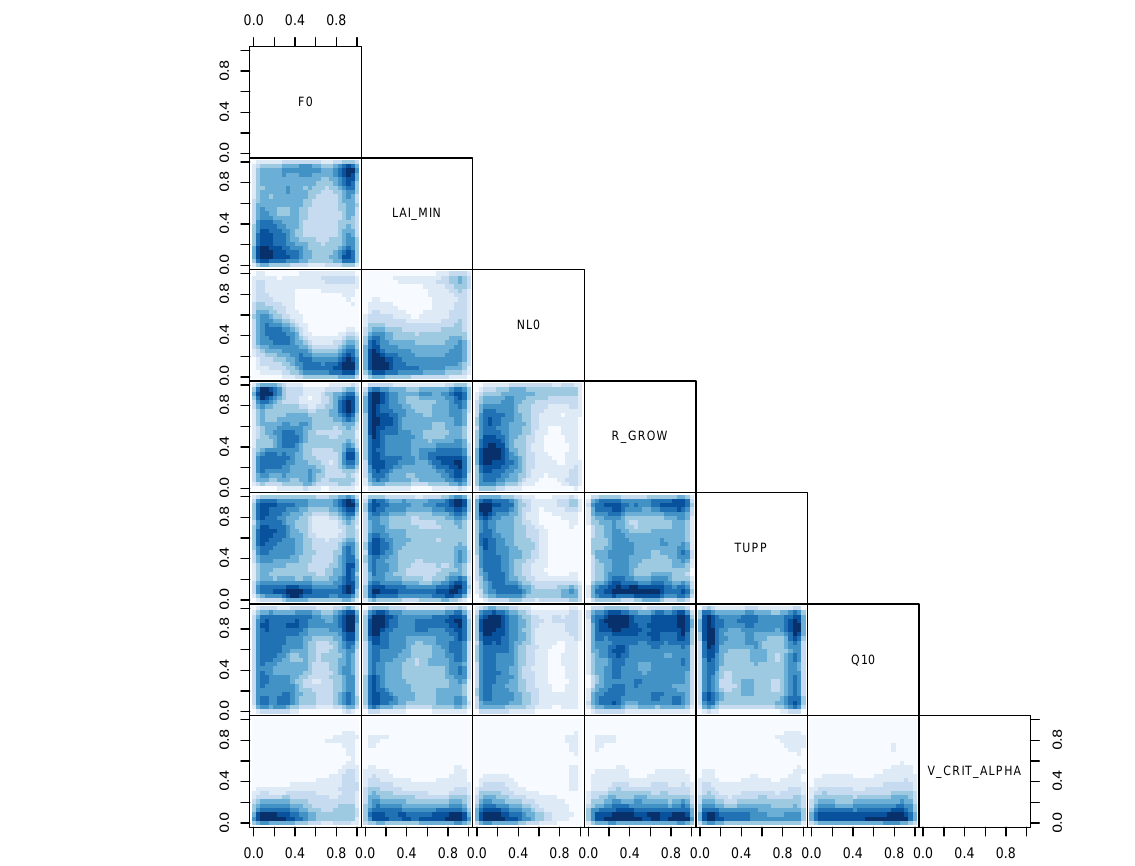
Figure 4. A density pairs plot of two-dimensional projections of parameter space. The blue areas represent the density of NROY points, using all of the data, with an assumed observational uncertainty of 0.05